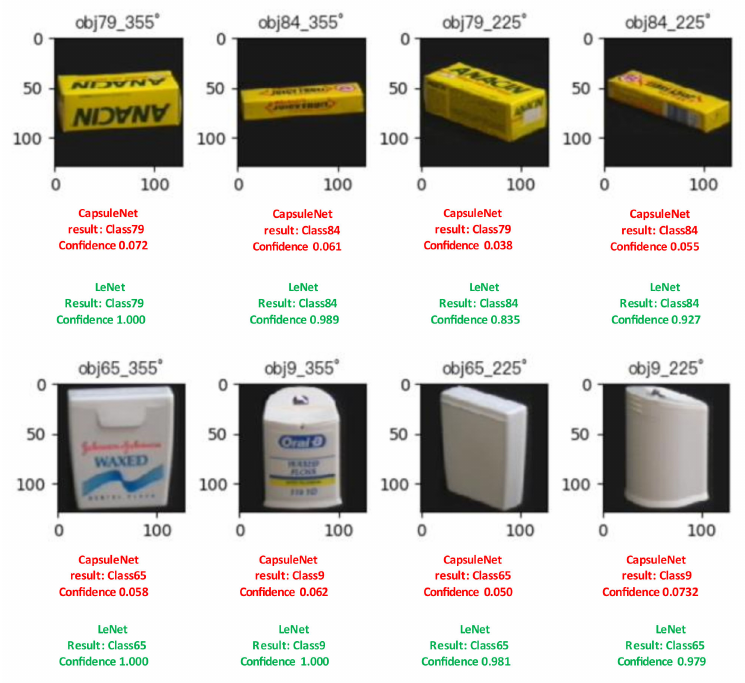
Figure 2. Capsule network and LeNet’s ability to classify rotating